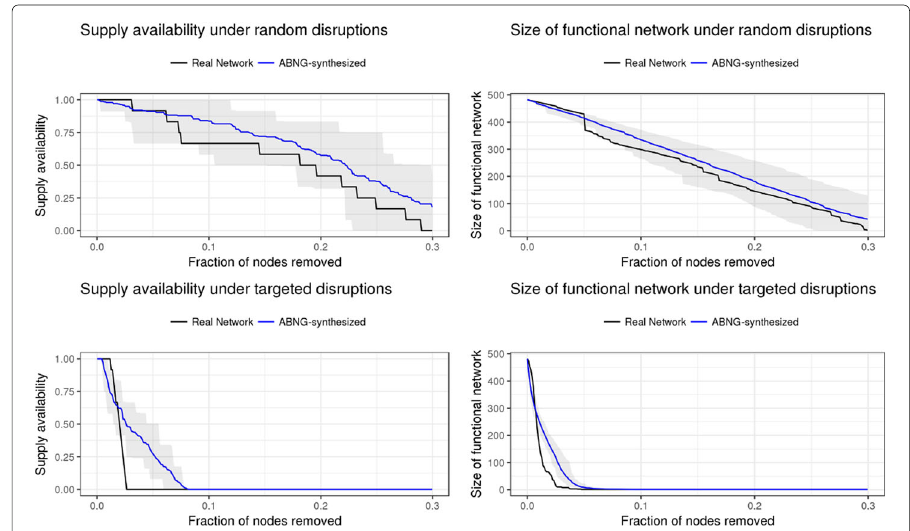
Fig. 7 Supply network of Electromedical and Electrotherapeutic Apparatus